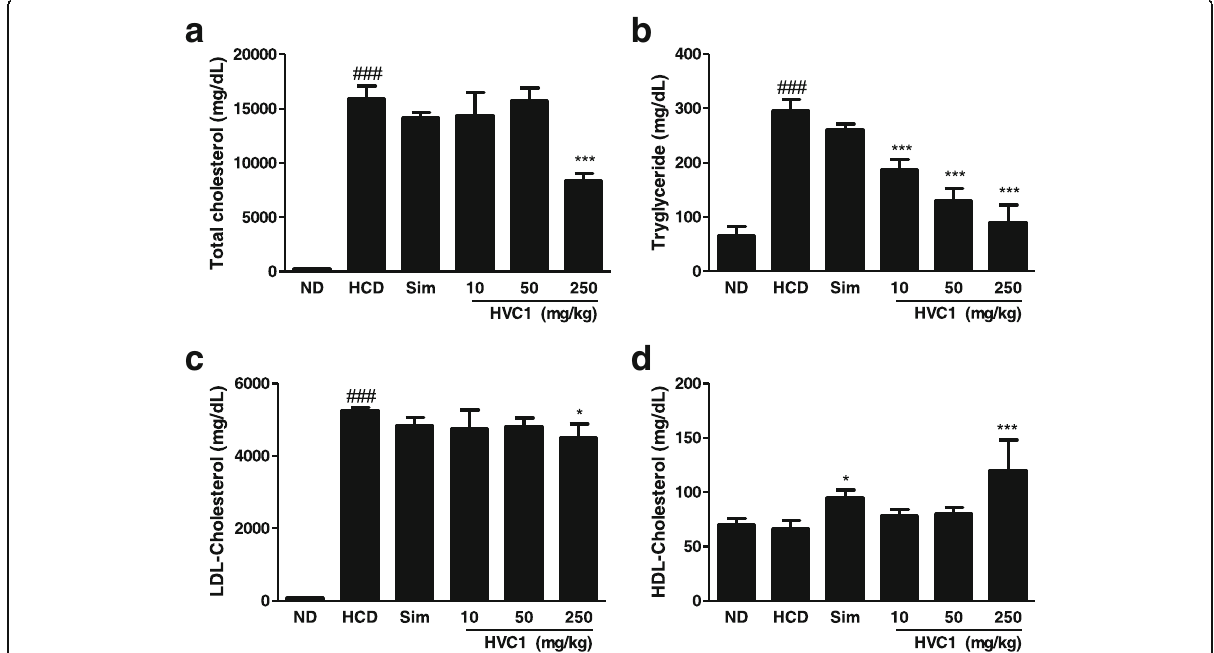
Fig. 2 Effect of HVC1 on the serum lipid profile in LDLR − / − mice fed a HCD. Total-cholesterol ( a ), triglyceride ( b ), LDL-cholesterol ( c ), HDL-cholesterol ( d ). ND: Normal diet group; HCD: High-cholesterol diet group; Sim: Simvastatin (10 mg/kg) treated with HCD group; HVC1: HVC1 treated with HCD group. The values represent mean ± S.D. (significant as compared to HCD, * p < 0.05, *** p < 0.001, significant as compared to ND, ### p <